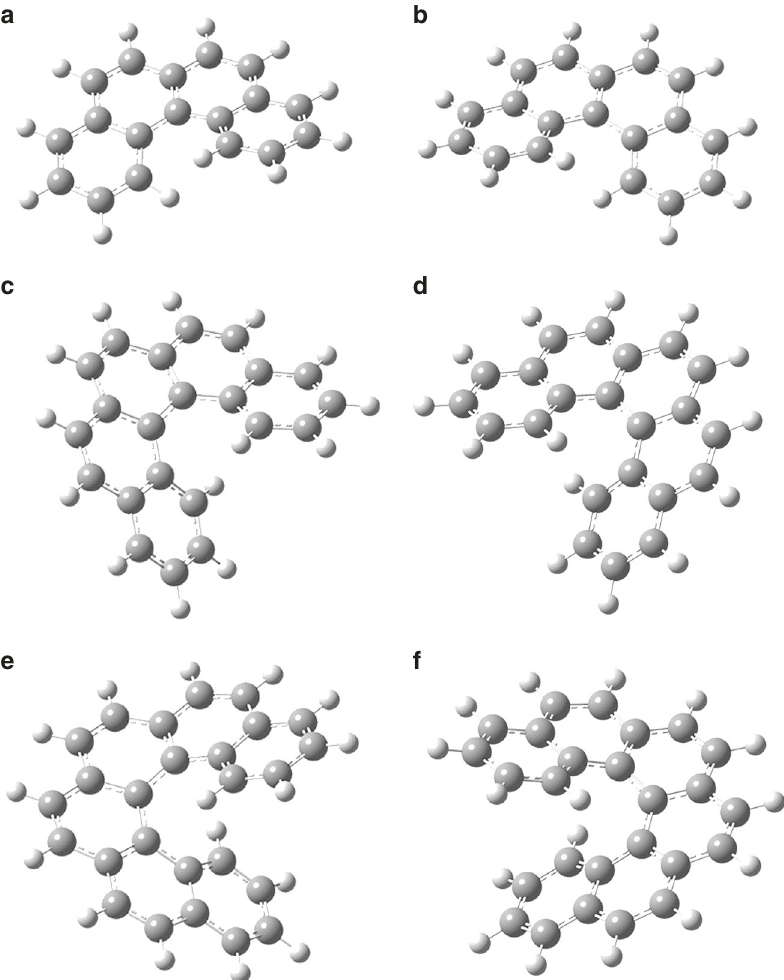
Fig. 1 Molecular structures of helicenes. a ( M )-[4]-helicene; b ( P )-[4]-helicene; c ( M )-[5]-helicene; d ( P )-[5]-helicene; e ( M )-[6]-helicene and f ( P